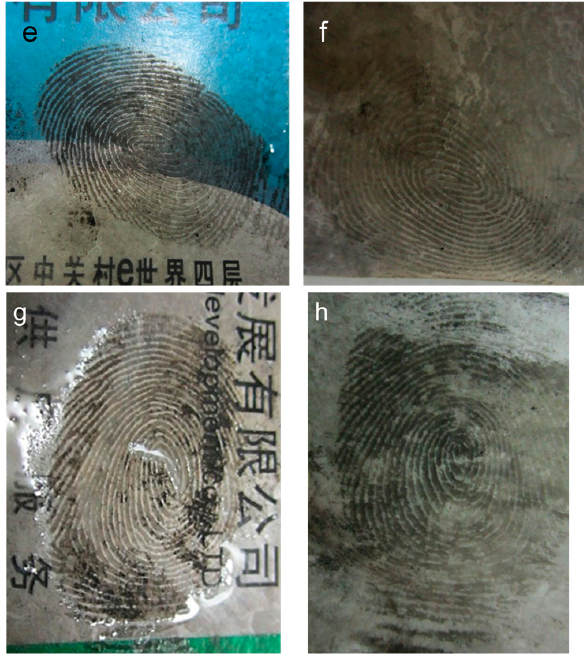
Figure 3. Fingermarks developed by the CSC method on several surfaces: ( a ) glass slide; ( b ) ceramic spoon; ( c ) aluminium sheet; ( d ) copper sheet; ( e ) cardboard; ( f ) adhesive tape; ( g ) paper card and ( h ) copy paper.